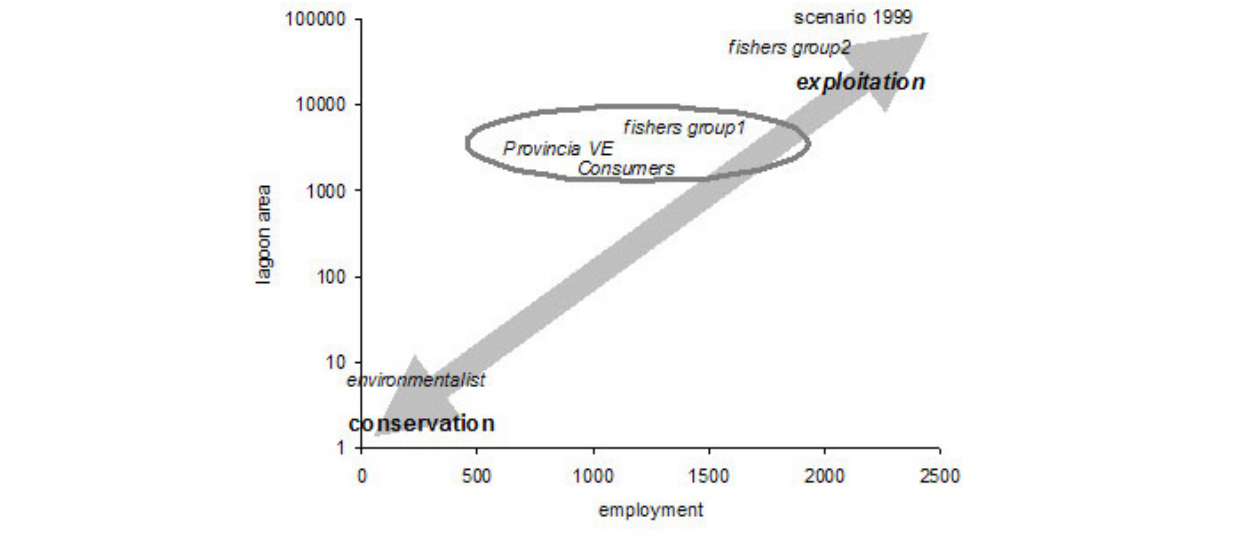
Fig. 4. Clam resource management scenarios. Grey arrow indicates, at the two extremes, the two extreme views relative to clam harvesting: the conservation, i.e., no harvesting, and the open access. In between there is an area of alternative views, currently supported by the stakeholders, among which we made the sensitive